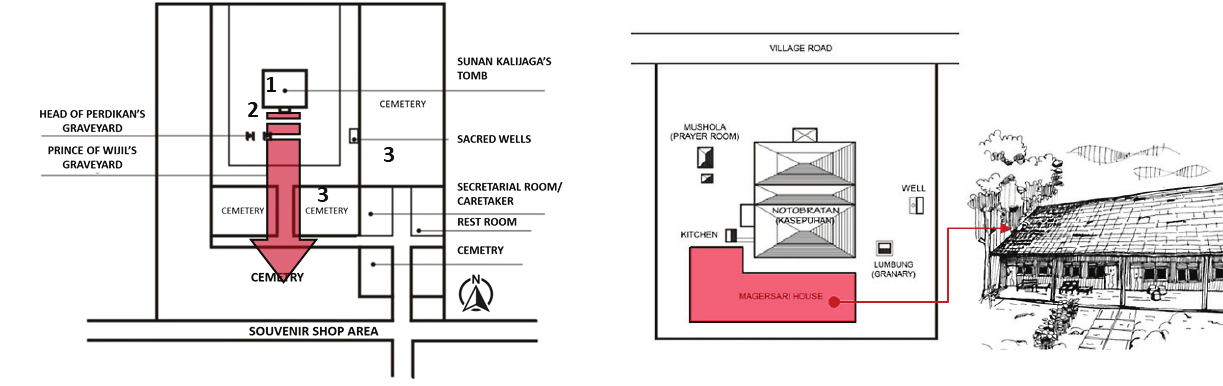
Figure 5. The hierarchical space in Sunan Kalijaga’s cemetery (source: Survey, 2017)